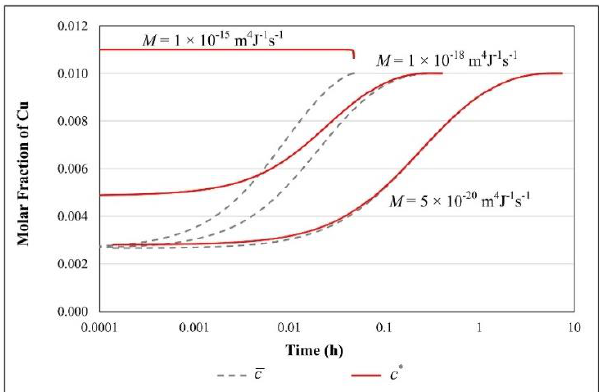
Figure 11. Time evolution of c and c ∗ for a spherical θ -Al 2 Cu precipitate dissolving in a finite matrix with three di ff erent values for the interfacial mobility. The number density of the precipitates is assumed to be 1.0 × 10 18 m − 3 .